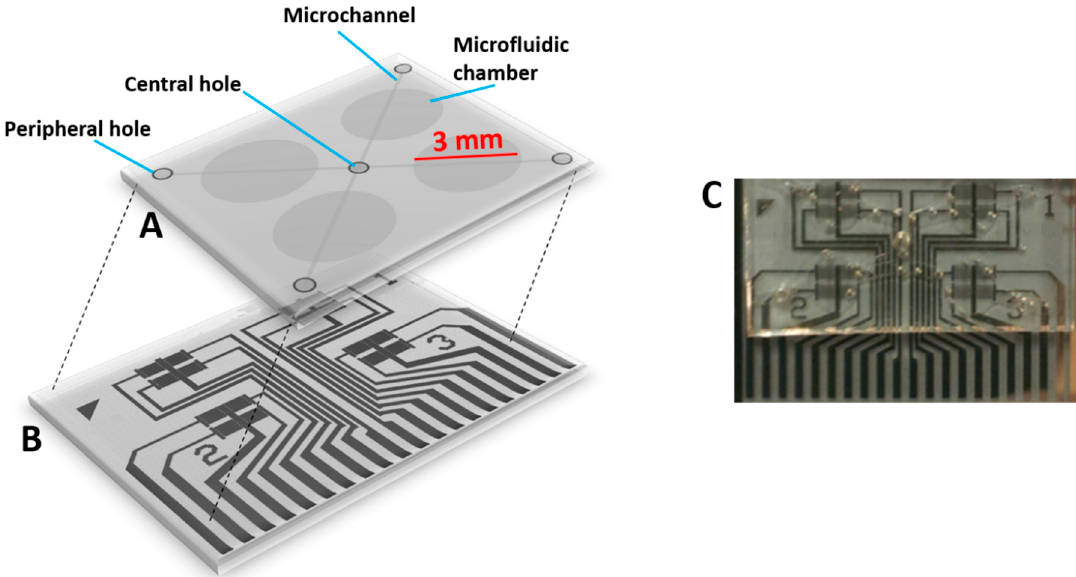
Figure 1. ( A ) microfluidic module of the platform with microchambers, microchannels, central and peripheral holes; ( B ) sensing module with four arrays of microelectrodes, each of which consists of four couples of interdigited electrodes. ( C ) Assembled device with microfluidic module aligned with electrodes array on the bottom.